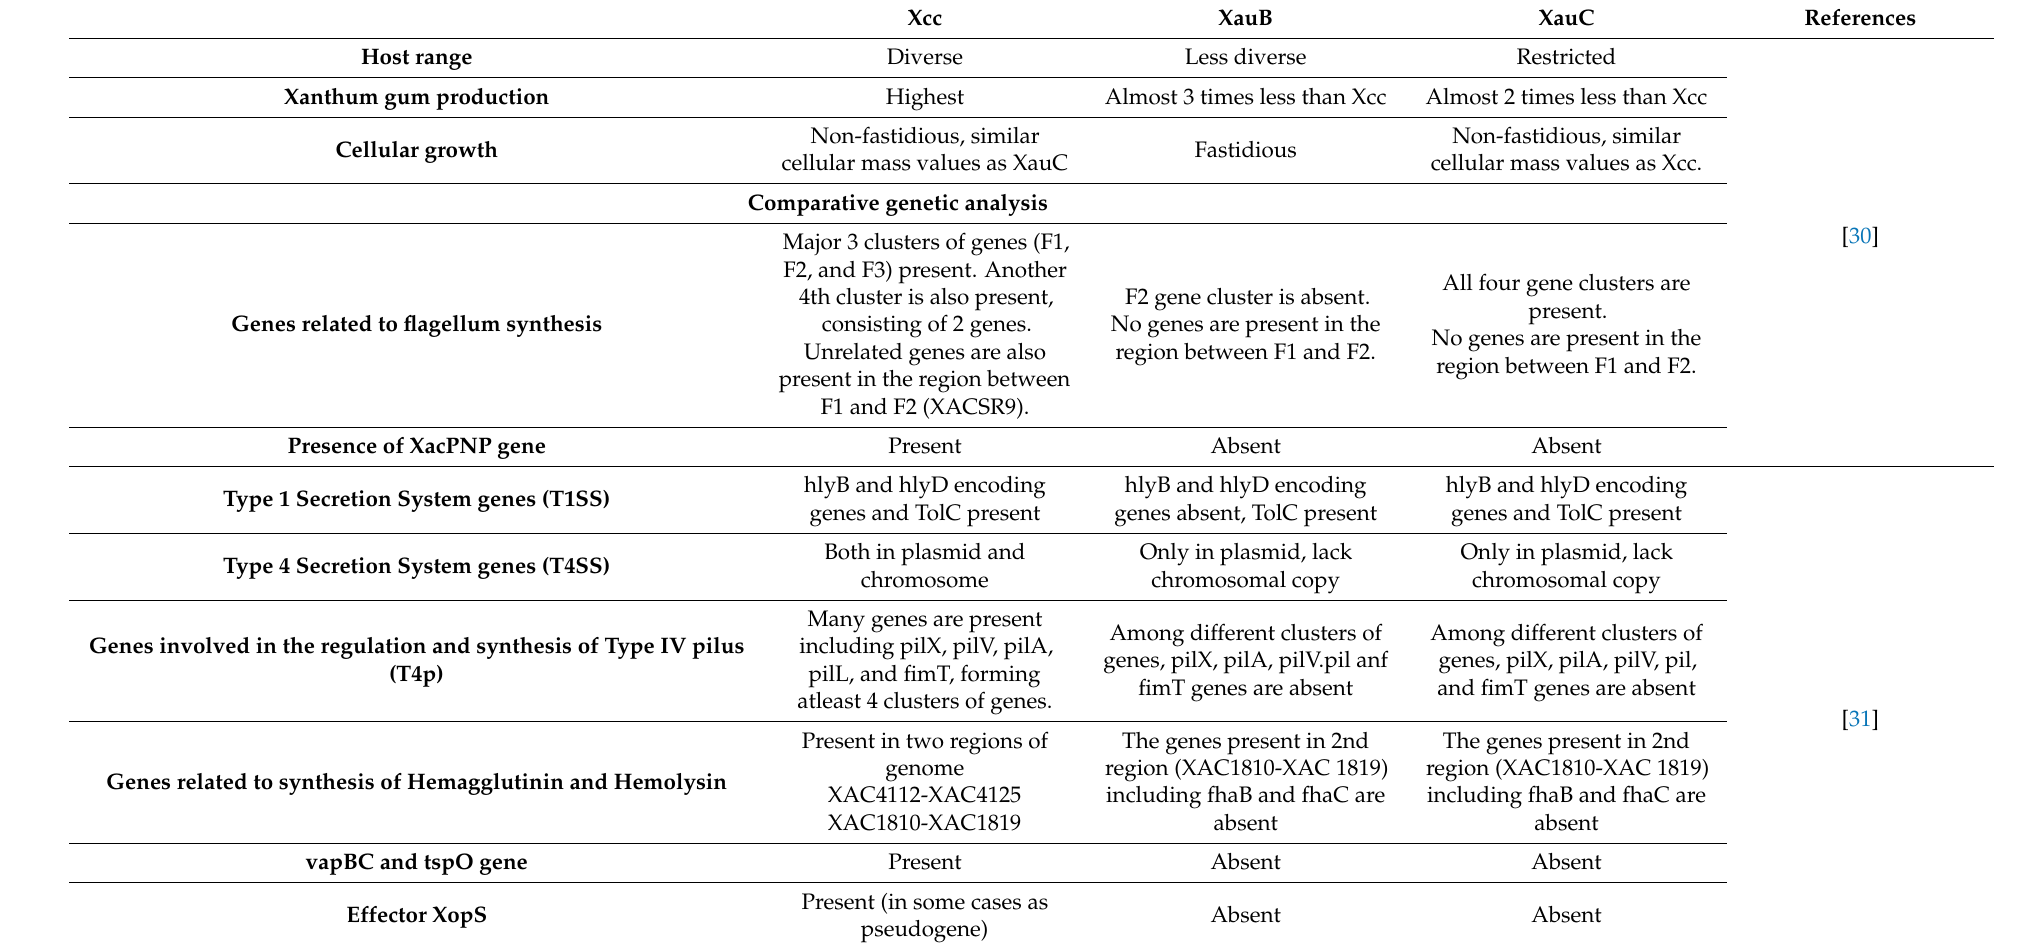
Table 2. Comparison of major types of citrus